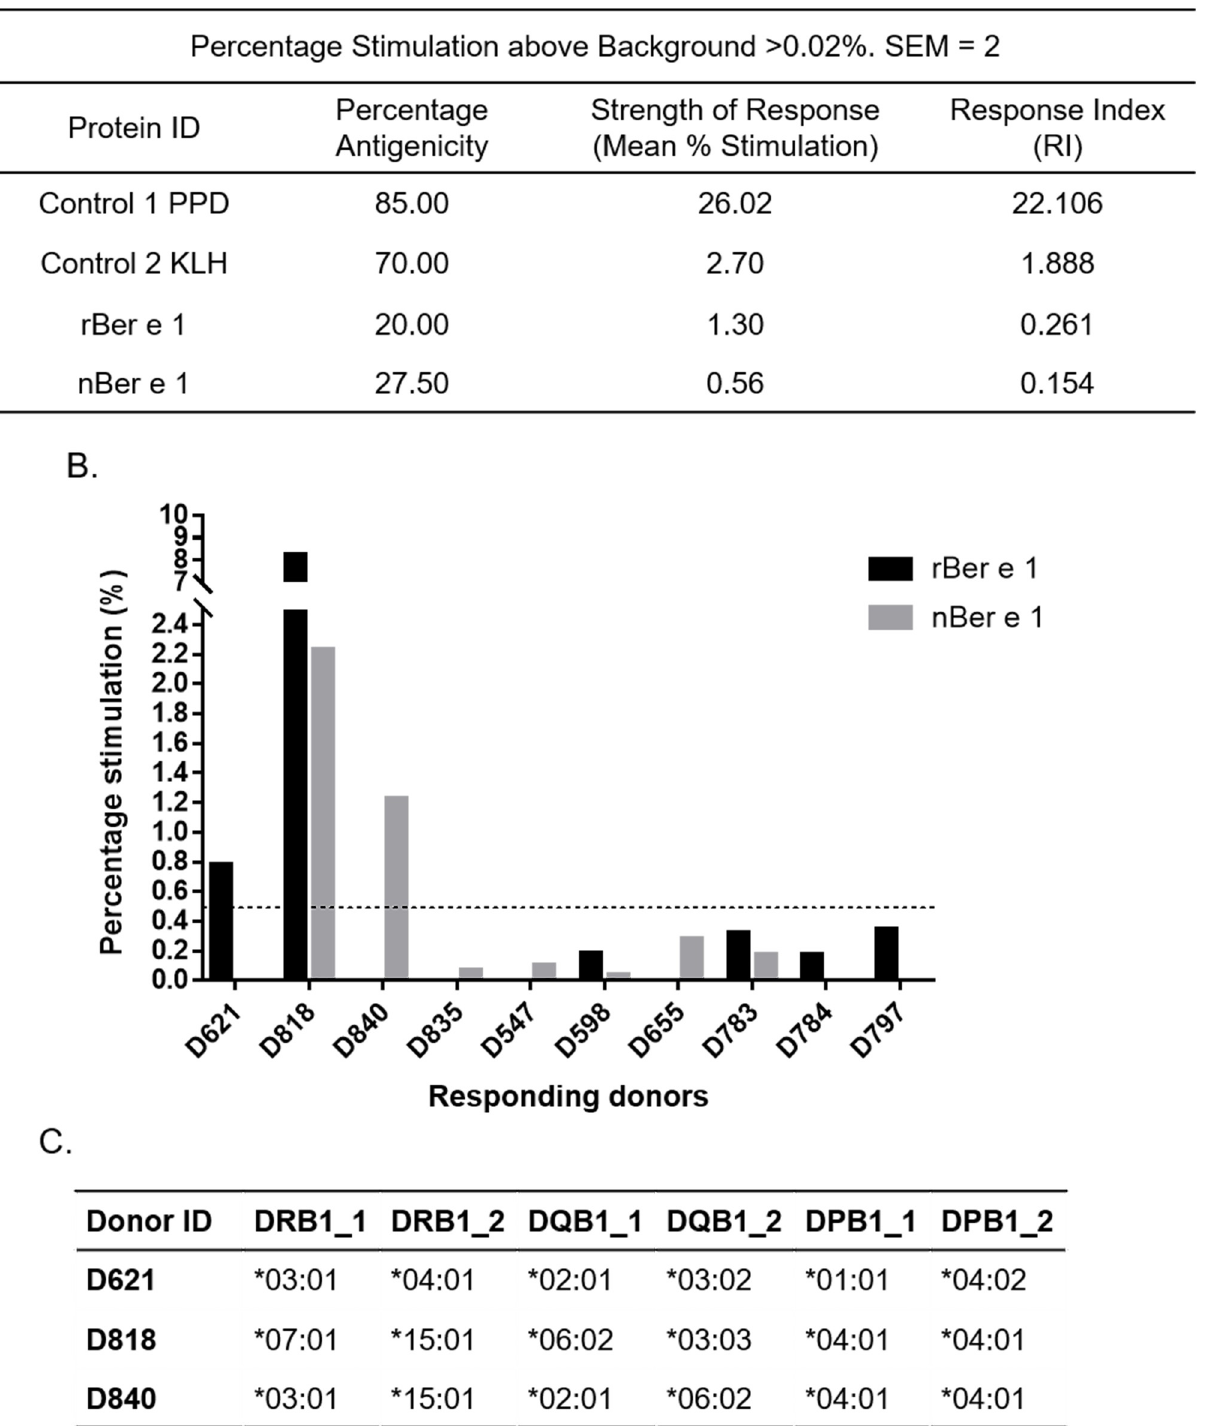
Fig 2. In vitro antigenicity of rBer e 1 and nBer e 1 by DC-T cell response assay. (A.) Response Index (RI) values for rBer e 1, nBer e 1 and reference protein from percentage antigenicity and stimulation data (percent stimulation above background � 0.02%, SEM = 2) (B.) Graph of responding donors with percentage stimulation above 0.02% (SEM = 2) after stimulating with nBer e 1 and rBer e 1. Dotted line indicates higher stimulation cut-off of 0.5%